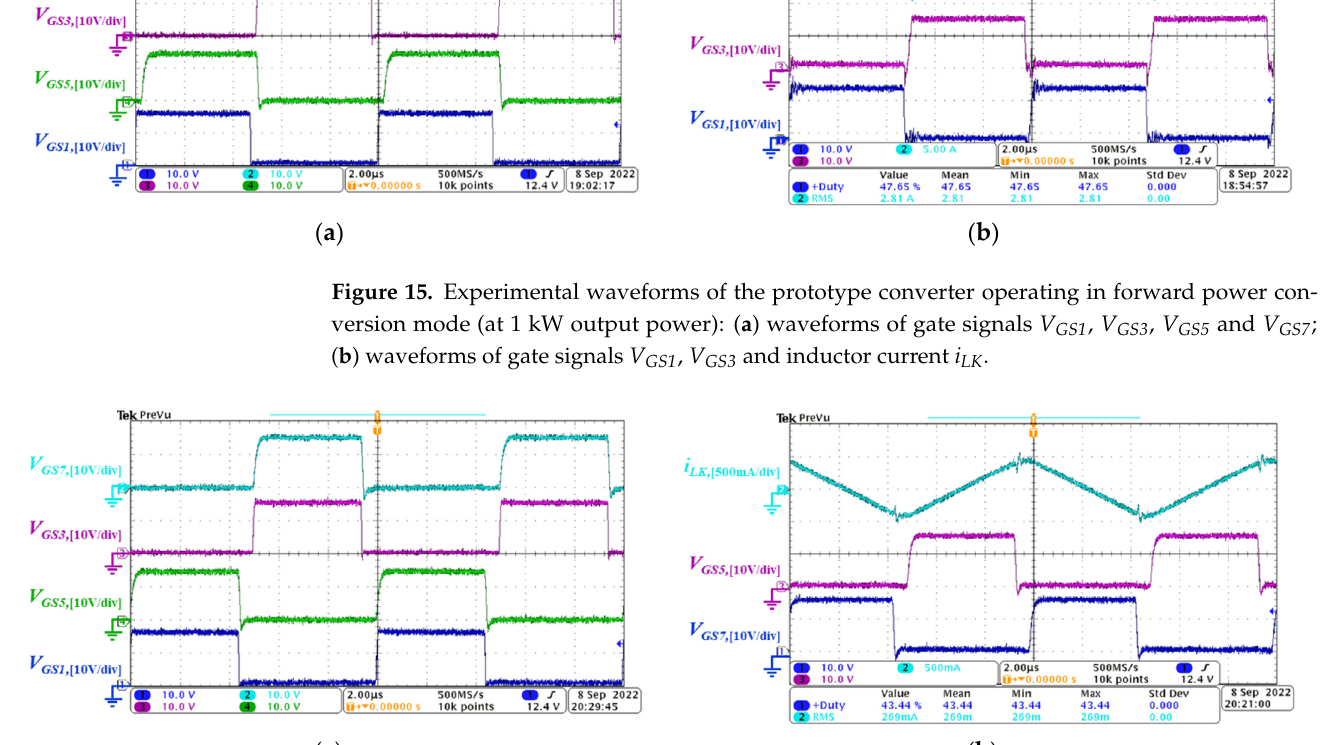
Figure 15. Experimental waveforms of the prototype converter operating in forward power conver- sion mode (at 1 kW output power): ( a ) waveforms of gate signals V GS1 , V GS3 , V GS5 and V GS7 ; ( b ) wave- forms of gate signals V GS1 , V GS3 and inductor current i LK .